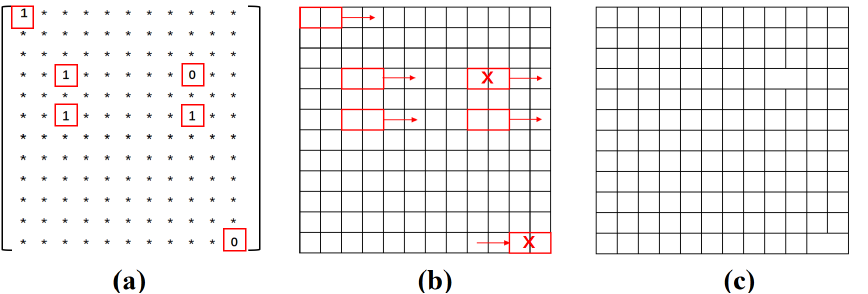
Figure 8. Demonstration of the first step of transforming the grid: ( a ) the horizontal pair label matrix; ( b ) scan and transform the grid; ( c ) the result of transformation.